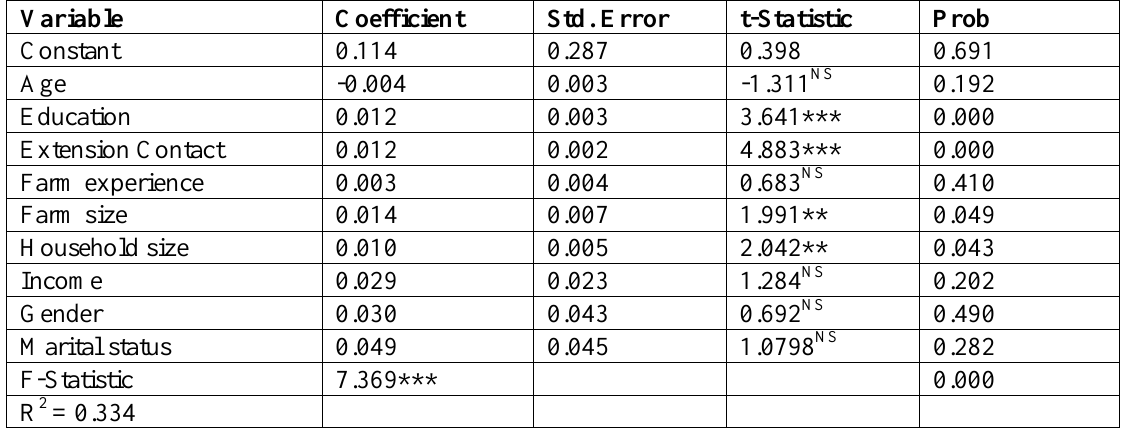
Table 5. Regression analysis of effect of socioeconomic characteristics on the level of